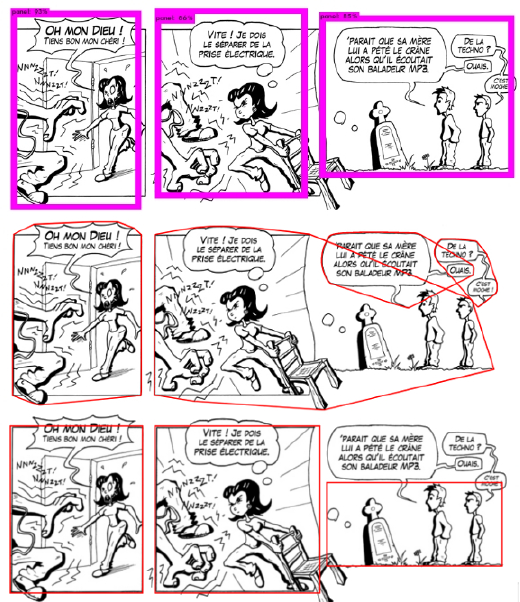
Figure 9. Panel detection on difficult pages. The first row shows detections from the CNN model. The second row shows detections from the algorithm in [6]. The last column is ground-truth regions from the eBDtheque dataset (defined as smallest graphics regions ignoring outgoing elements).